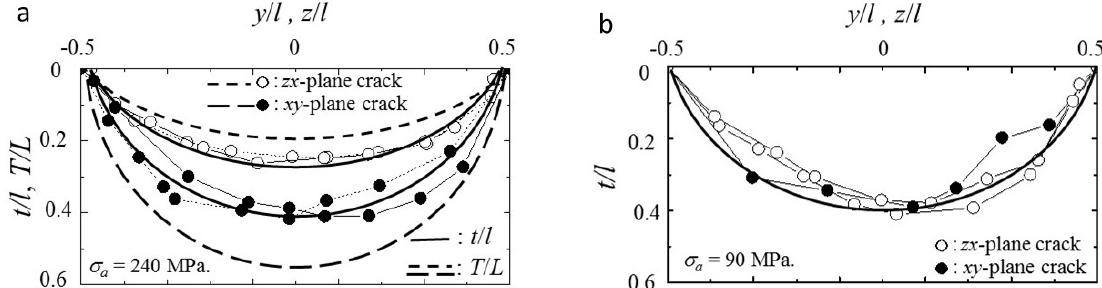
Figure 6: Profile of the crack face in terms of dimensionless sizes: (a)  a = 240 MPa; (b)  a = 90 MPa.